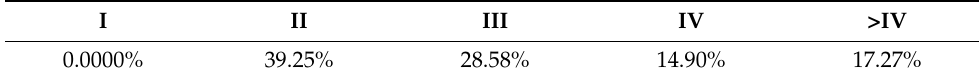
Figure 3. Surface distribution of TN in the Bohai Sea ( a ) and Laizhou Bay ( b ) and distribution of seawater of different quality levels in the Laizhou Bay ( c ). Table 3. The area proportions of each seawater quality standard grade.